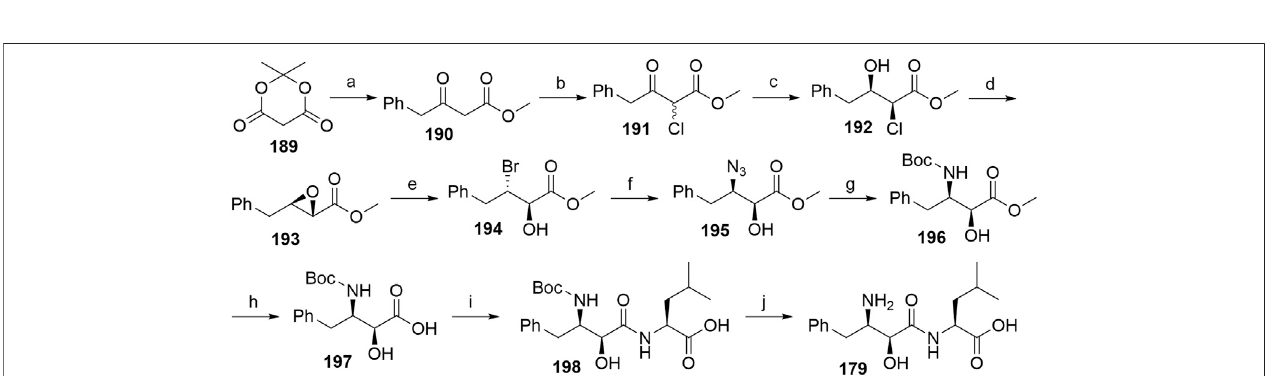
SCHEME 33 | Alternative route for the syntheses of bestatin ( 179 ). Reagents and conditions: a) phenylacetyl chloride, pyridine, CH 2 Cl 2 , 0 ° C, 92% yield; b) SO 2 Cl 2 , 0 ° C, overnight,88%yield;c)Ru